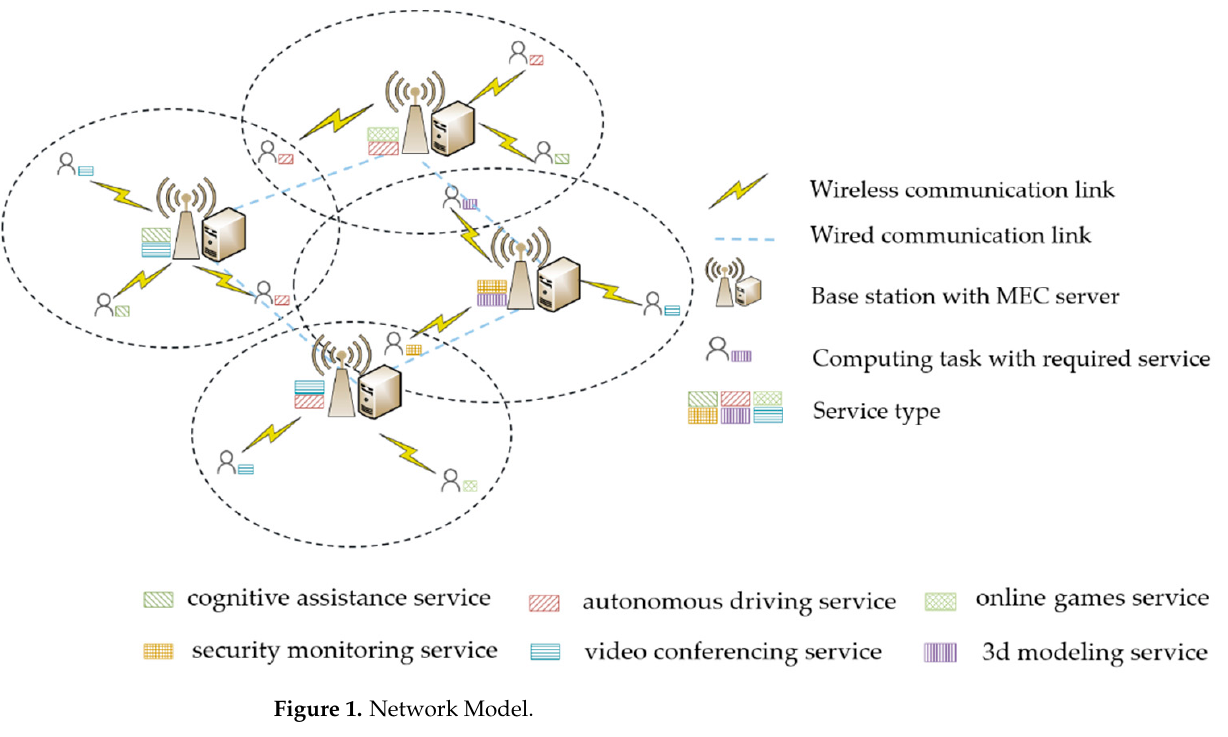
Figure 1. Network Model.